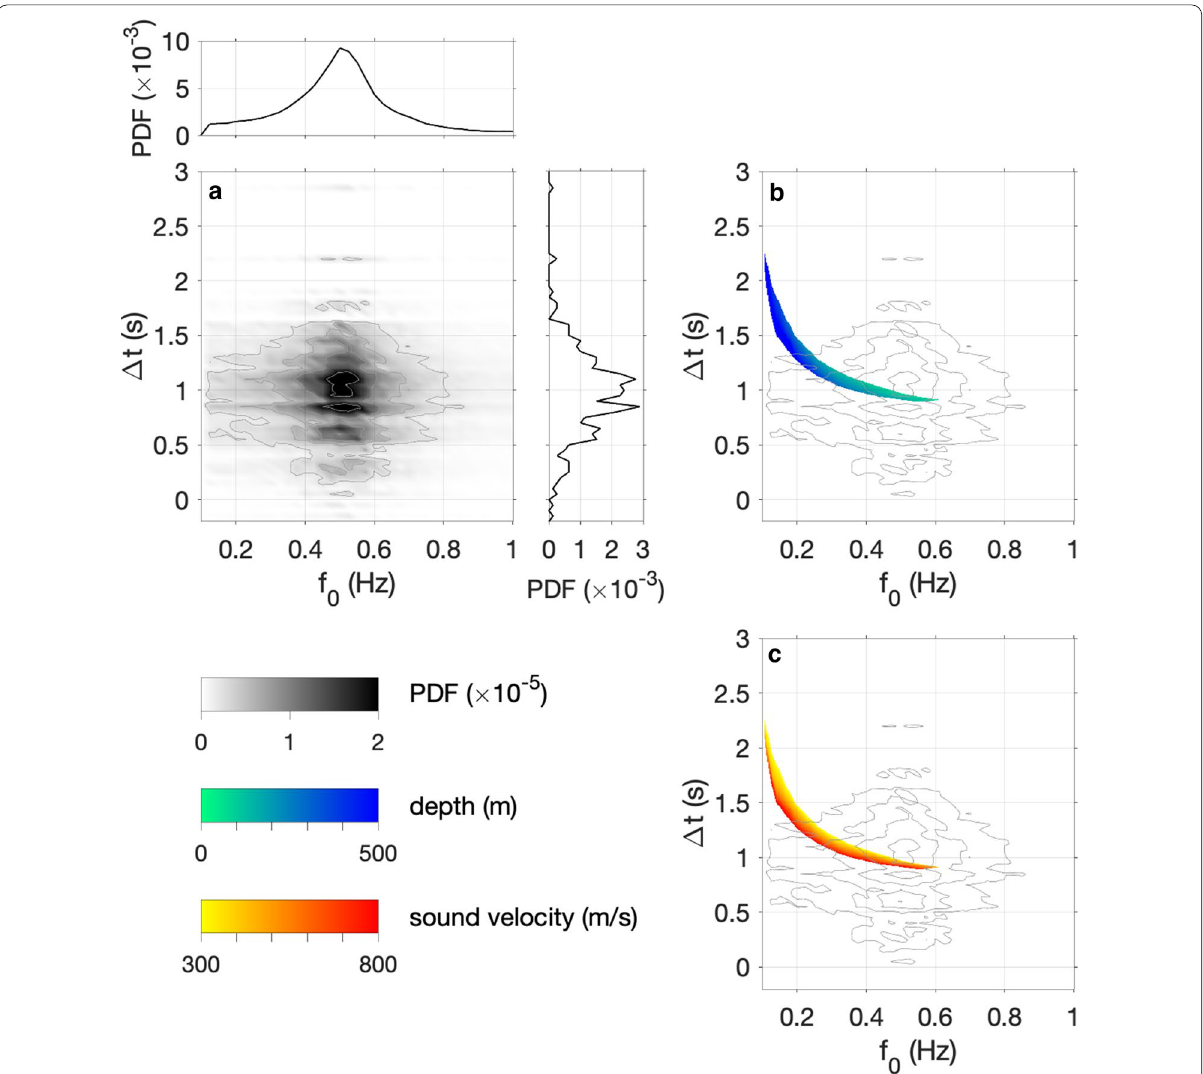
Fig. 4 PDF distribution of observed parameters and areas where the solutions exist for the combined equation. a PDF distribution of observed parameters ( f 0 and (cid:31) t ). This PDF is normalized so that the sum is 1. The PDF distribution of f 0 is centered at ∼ 0.5 Hz. The spectral structure of the amplitude spectrum of f 0 for each event is reflected in this distribution. The PDF distribution of the (cid:31) t axis shows the variation in (cid:31) t of all events. b, c The range of the observed parameters ( f 0 and (cid:31) t ), which can provide realistic depths and sound velocities inside the vent (colored arcuate areas). The colors show the values of estimated b depth and c sound velocity. These colored arcuate areas are narrow compared with the observed PDF distribution (gray contours). When the observed parameters included in the uncolored areas are substituted into the combined equation, the equation does not produce appropriate solutions. These figures show the cases in which the closed radius of the frustum pipe ( a c ) is 58